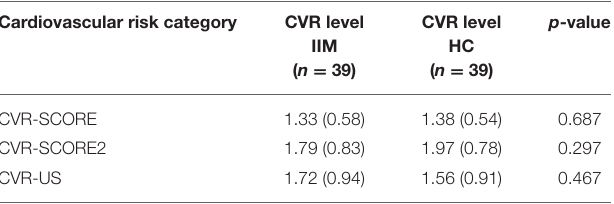
TABLE 5 | Comparison of the cardiovascular risk levels in the cardiovascular risk categories between IIM and